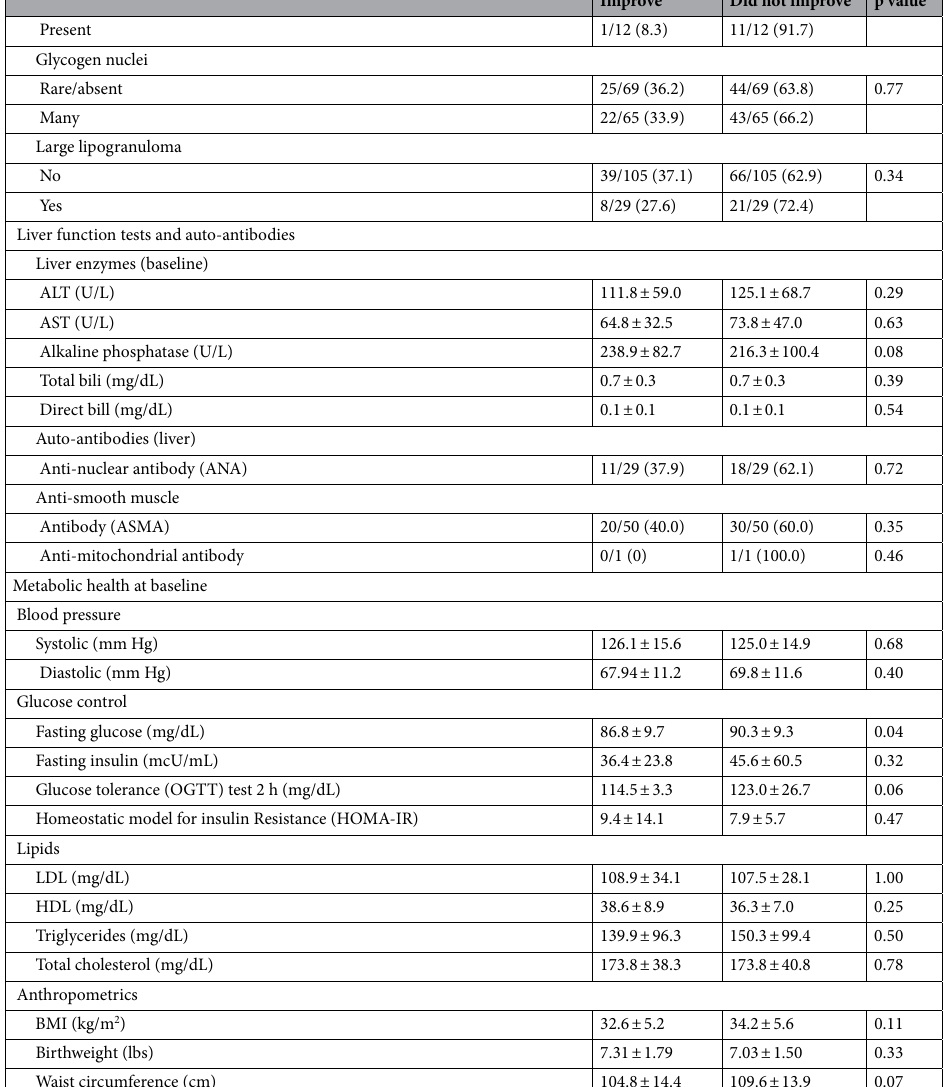
Table 2. NASH improvement* from baseline to 96 weeks. *Based on biopsy